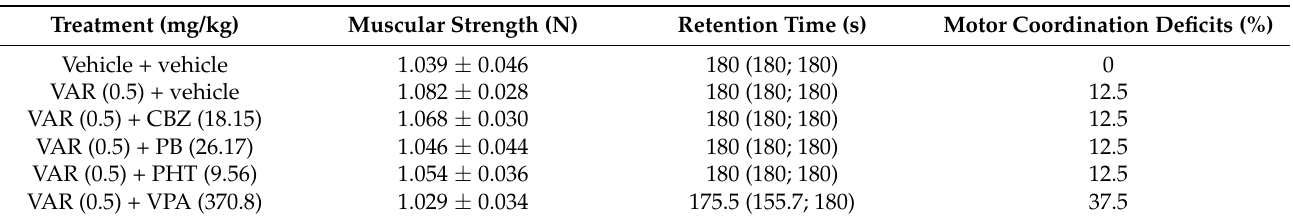
Table 3. Influence of varenicline (VAR) alone and its combination with four classic ASMs on skeletal muscular strength, long-term memory, and motor coordination in